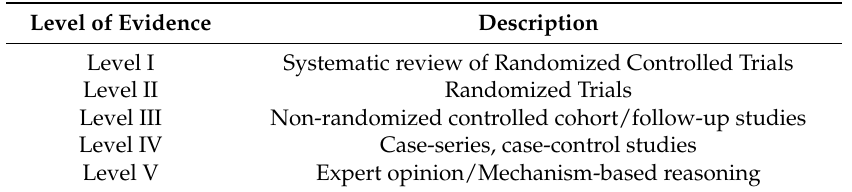
Table 1. Oxford Centre for evidence-based medicine 2011 levels of evidence.